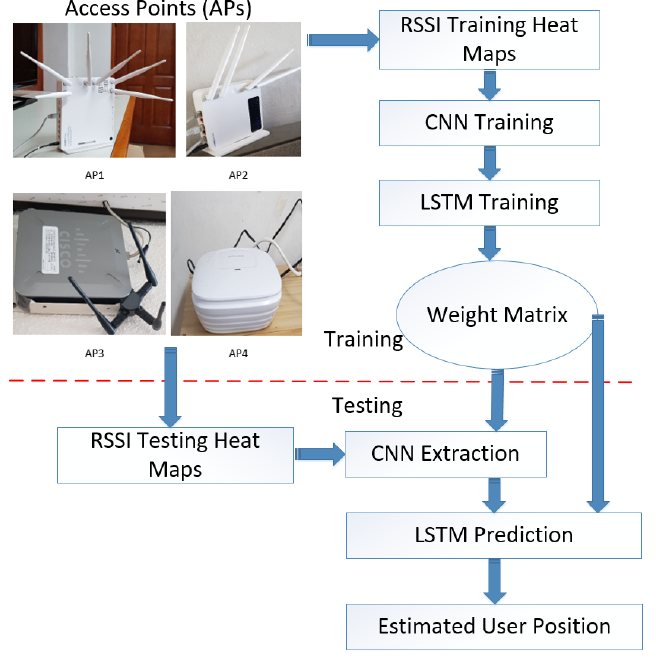
Figure 4. Localization process.